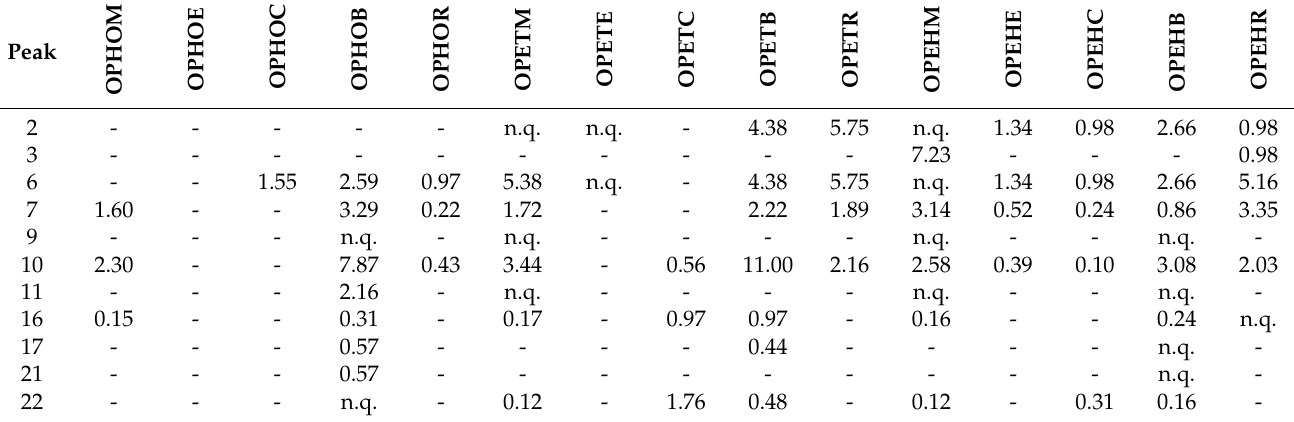
Table 7. Quantification of the identified compounds in the analyzed OFP extract samples (expressed as a weight/weight percentage (% w / w ) respect to the weight of the dry extract reported in Table